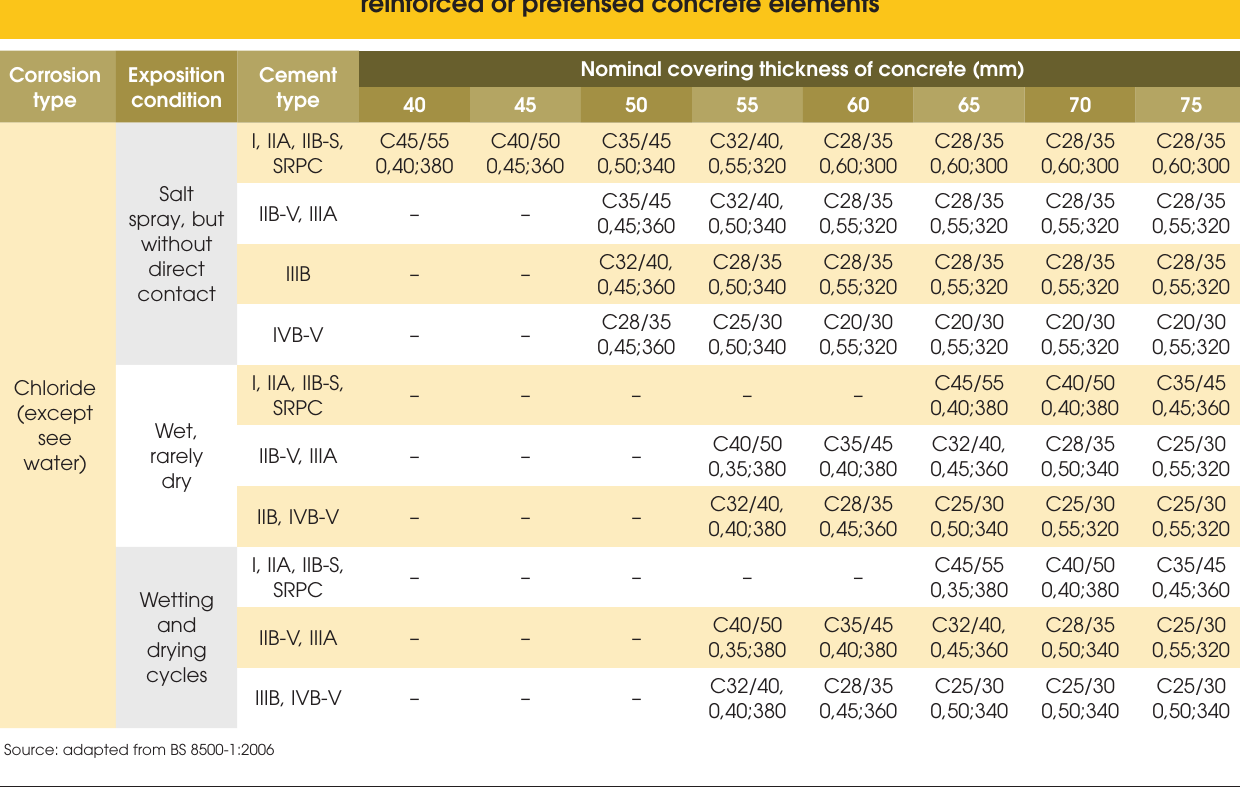
Table 7 – Specifications to attend service life of 100 years in buried reinforced or pretensed concrete